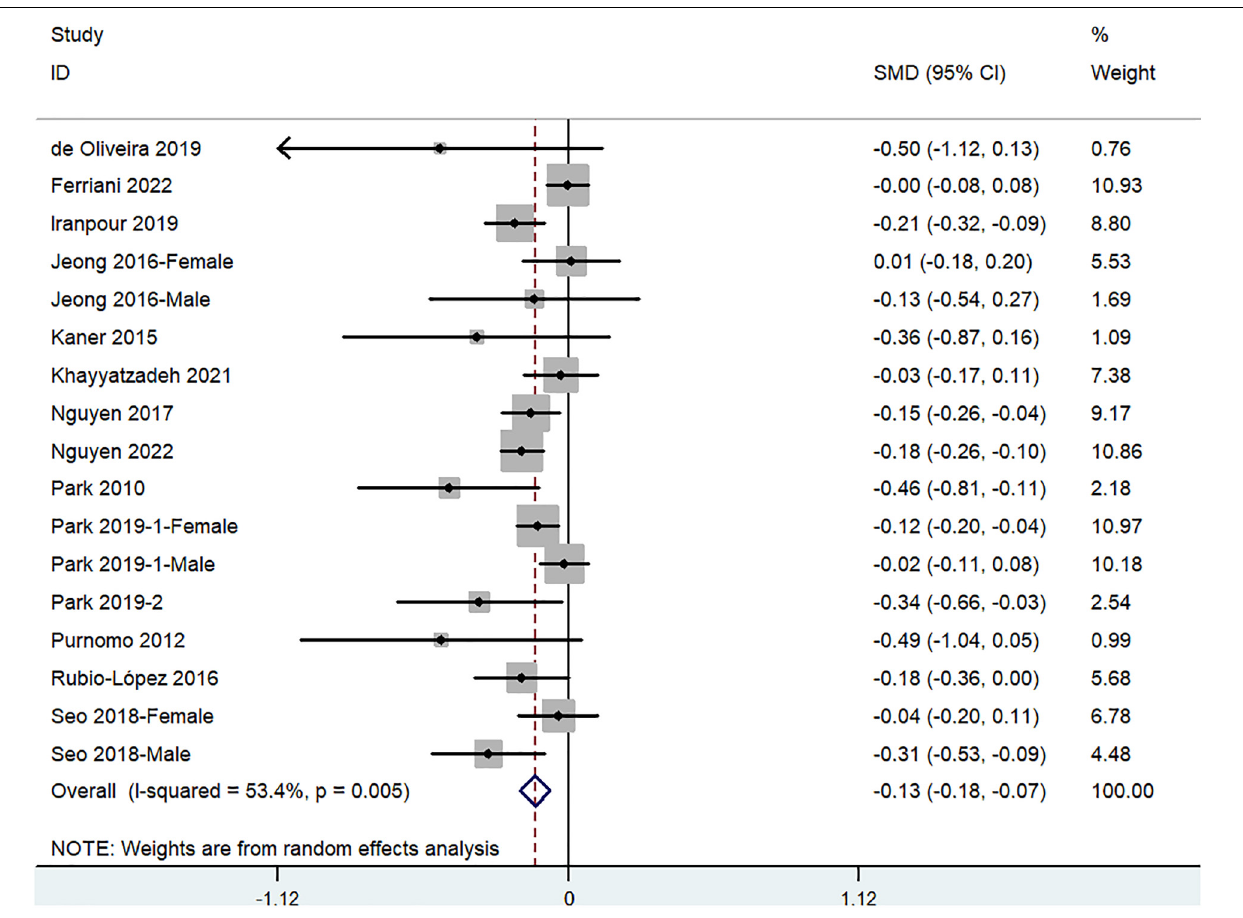
FIGURE 3 | Forest plot of meta-analysis: SMD of dietary vitamin A intake for depression vs. control subjects.